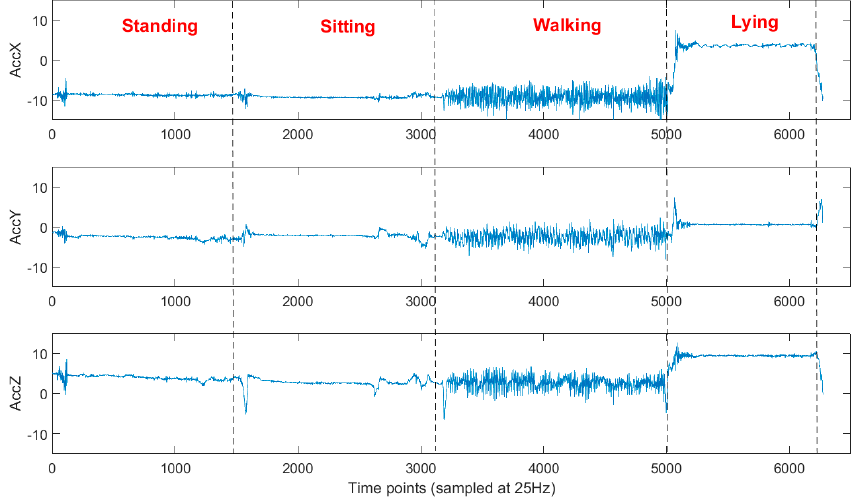
Figure 3. Acceleration signals while performing activities of daily living (ADLs).